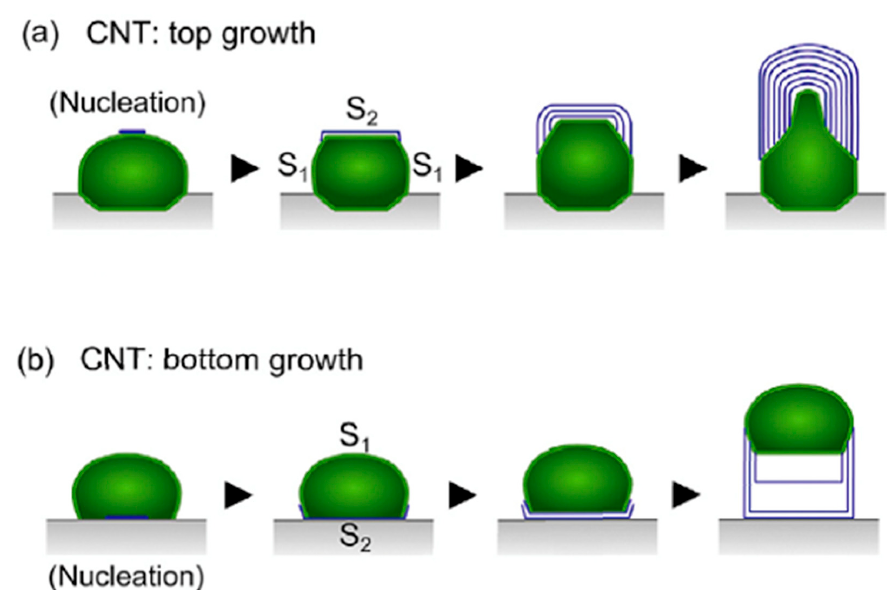
Figure 3. Nucleation and growth alternatives: Top nucleation and growth ( a ) vs. bottom nucleation and growth ( b ). The mechanism is just the same. Once a nucleation occurs, the carbon concentration inside the particle is reduced. No further nucleation occurs on other regions of the particle. The two reaction steps are the surface gas decomposition (at S 1 ) and the C bulk diffusion flux to the nucleation and growth regions (at S 2) .